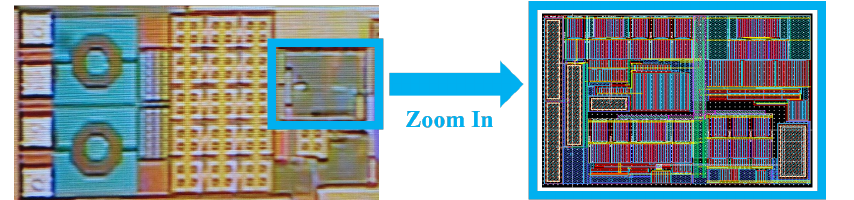
Figure 12. Location of the current/voltage reference circuit inside the microphotography of the whole passive temperature sensor and a zoomed-in view of its layout. Table 1. Elements and transistor sizes of the current source core.